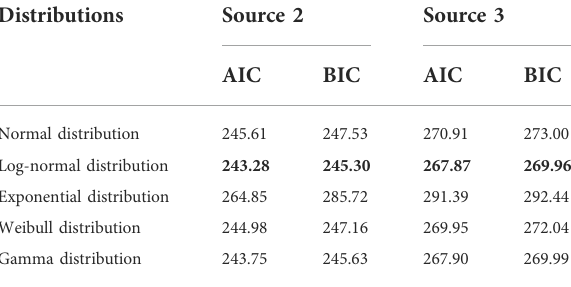
TABLE 2 AIC and BIC results of fi ve candidate marginal